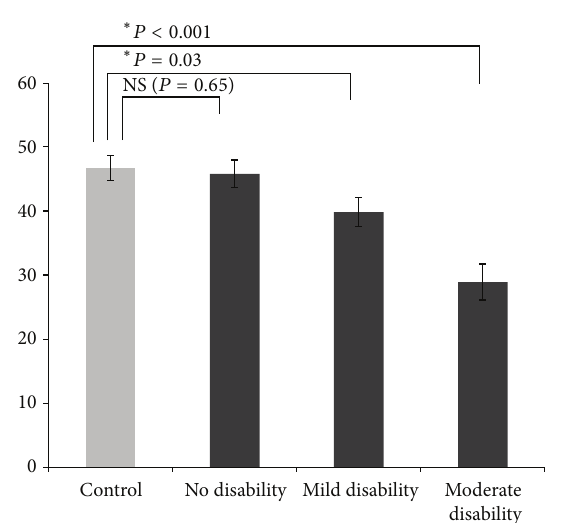
Figure 1: The Mean Interaural Time Difference on the Sound Lateralization Test (in 𝜇 sec) for the control and three disability- stratified groups. ∗ Signifies that the difference between the control group and MS groups was statistically significant ( 𝑃 < 0.05 ).